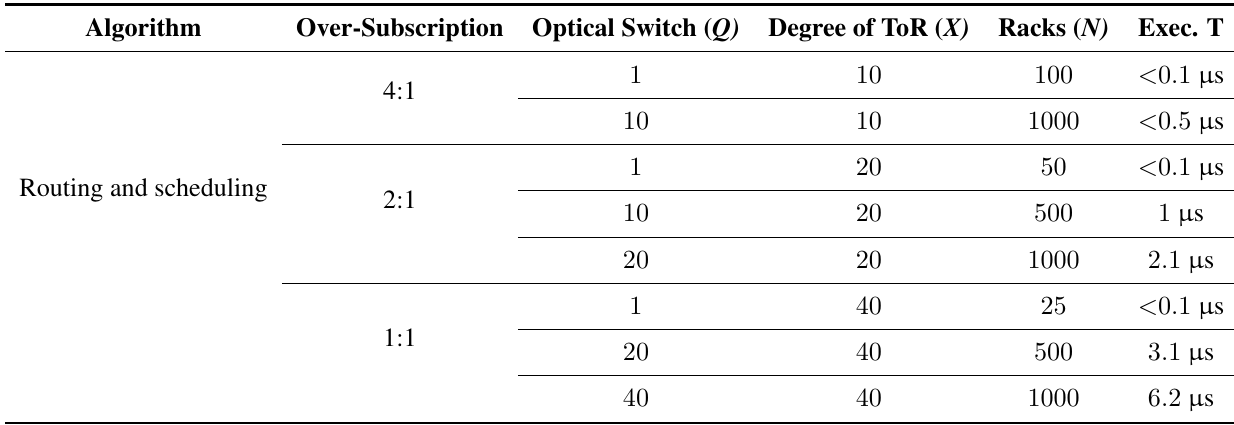
Table 2. Performance of the Control